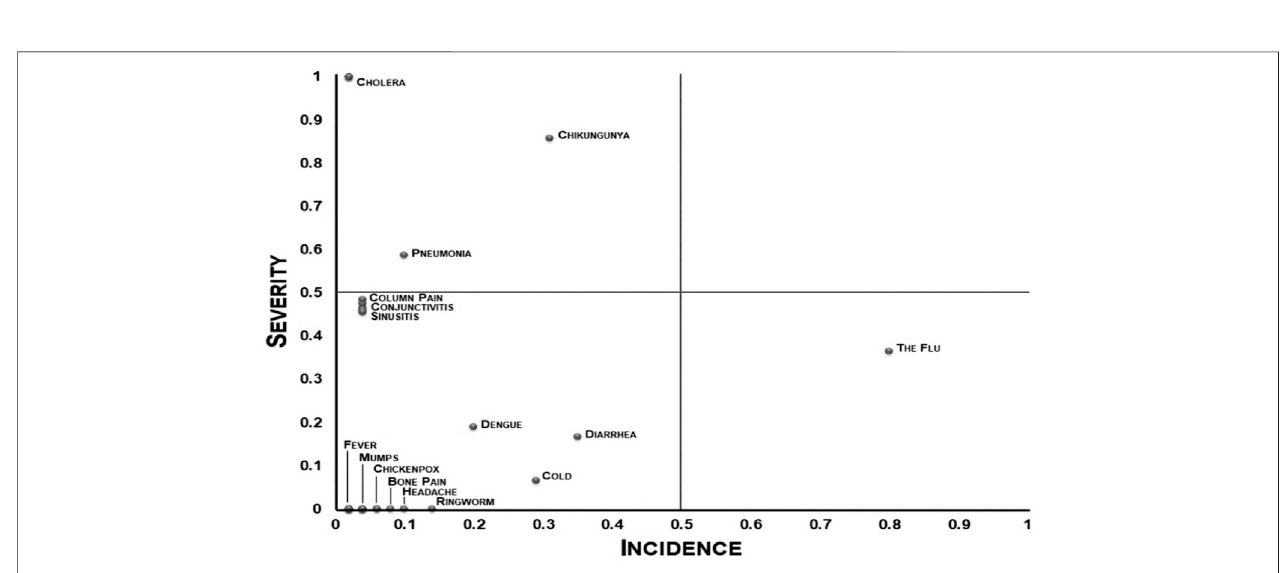
FIGURE 7 | Map of disease incidence and severity perceived by farmers in